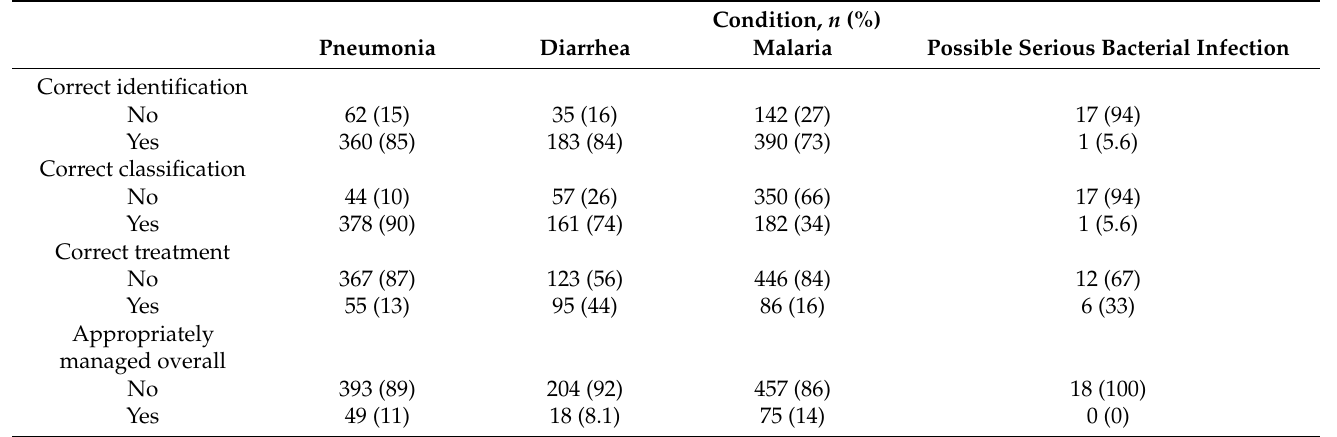
Table 4. Diagnosis, classification, and treatment of sick children by health workers at LLPHF.